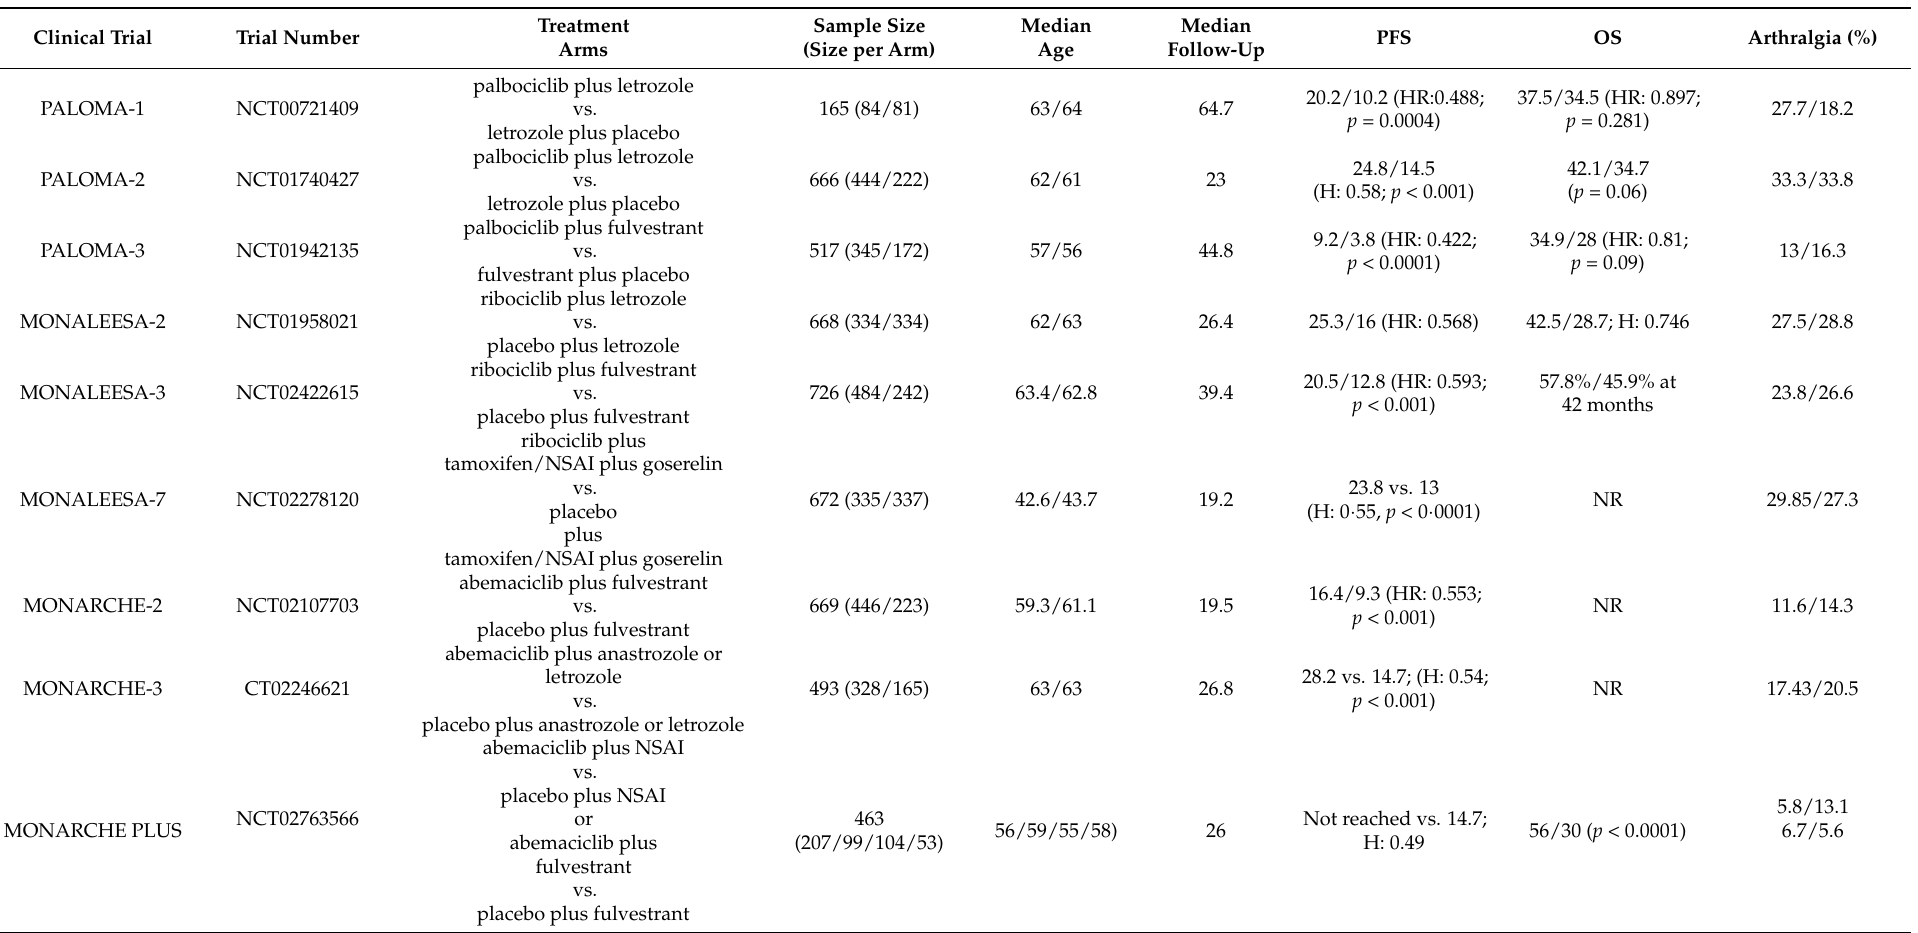
Table A1. Clinical trials of CDK4/6 inhibitors and the treatment-related arthralgia rates in breast